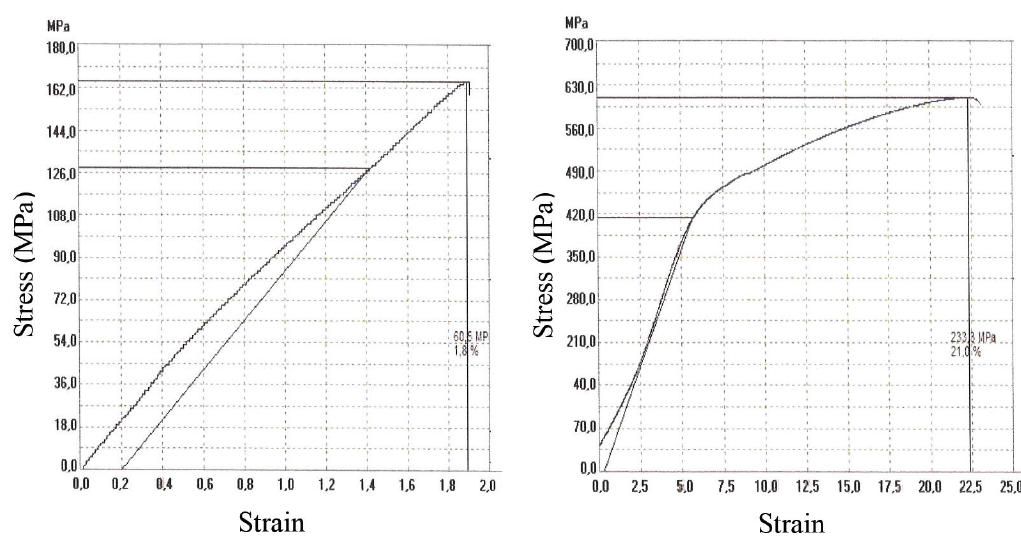
Figure 6. Stress–strain curves obtained from the tensile test on the extracted sample (first and second cycles).